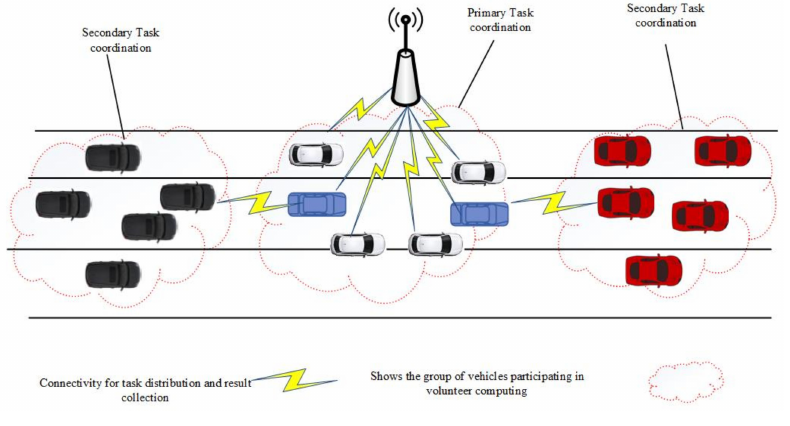
Figure 4. Hybrid VCBV